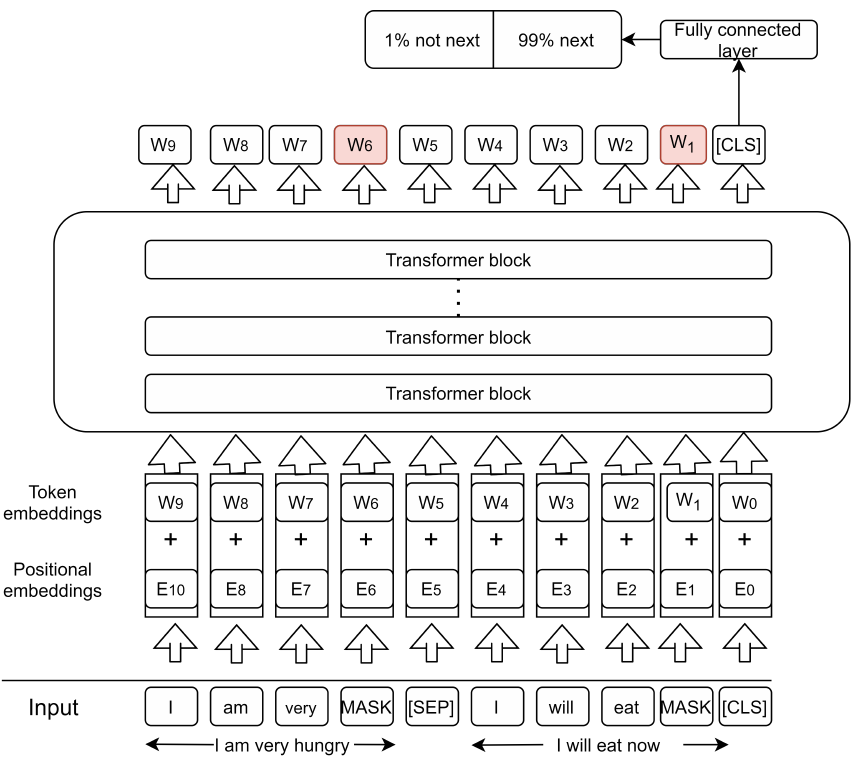
Figure 3. Bidirectional Encoder Representation from Transformers (BERT) training input and BERT training tasks: the first task is to predict masked words, and the second task makes the next sentence prediction.